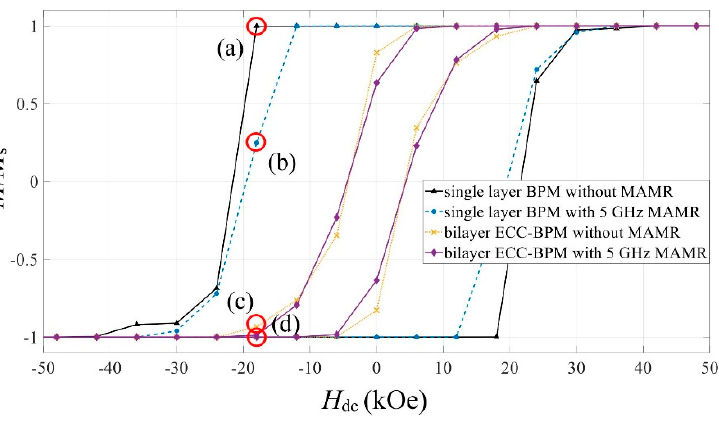
Figure 4. The hysteresis loops of the single-layer BPM and the bilayer ECC-BPM with and without MAMR ( A dot = 0.14 pJ/m for both media).